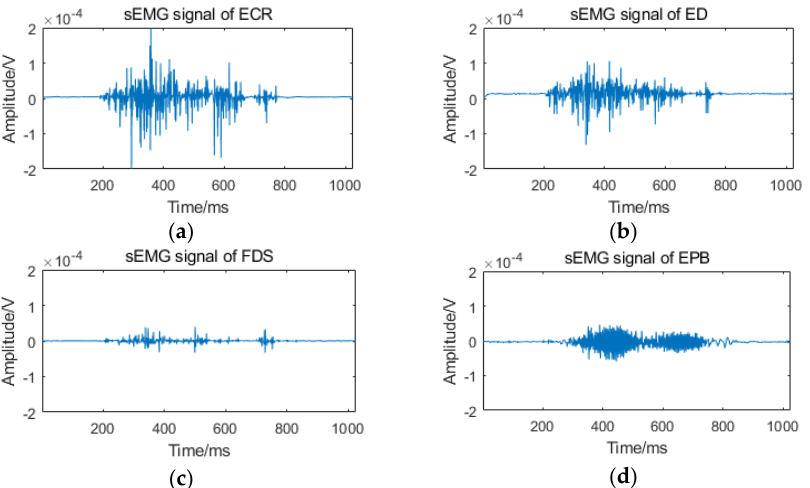
Figure 8. Collected original sEMG signals: ( a ) sEMG signal of ECR; ( b ) sEMG signal of ED; ( c ) sEMG signal of FDS; ( d ) sEMG signal of EPB.